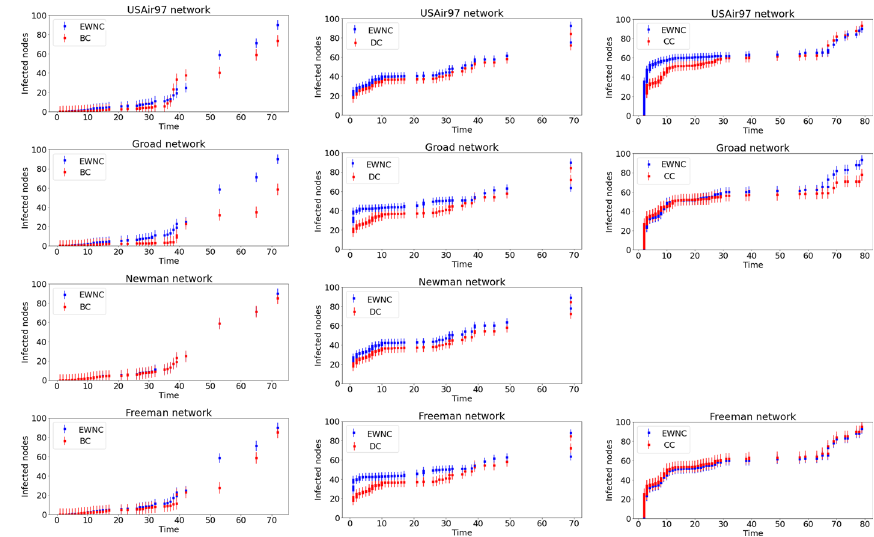
Fig. 2 The comparison of EWNC with other classical centrality measures in real networks. The real network data are obtained from USAir97 network, Groad network, Newman network and Freeman’s network.